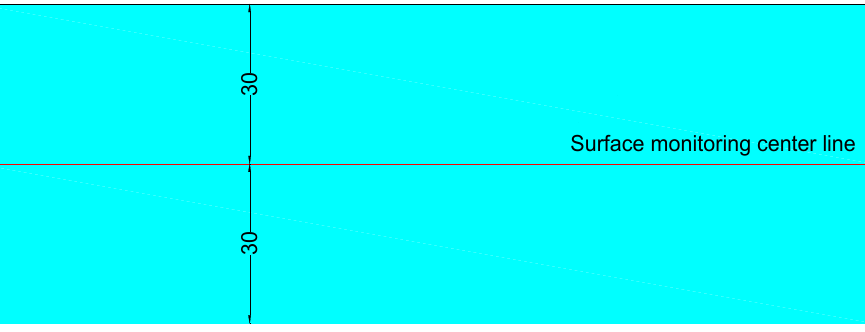
Figure 12. Location of the center line of the surface surveying.